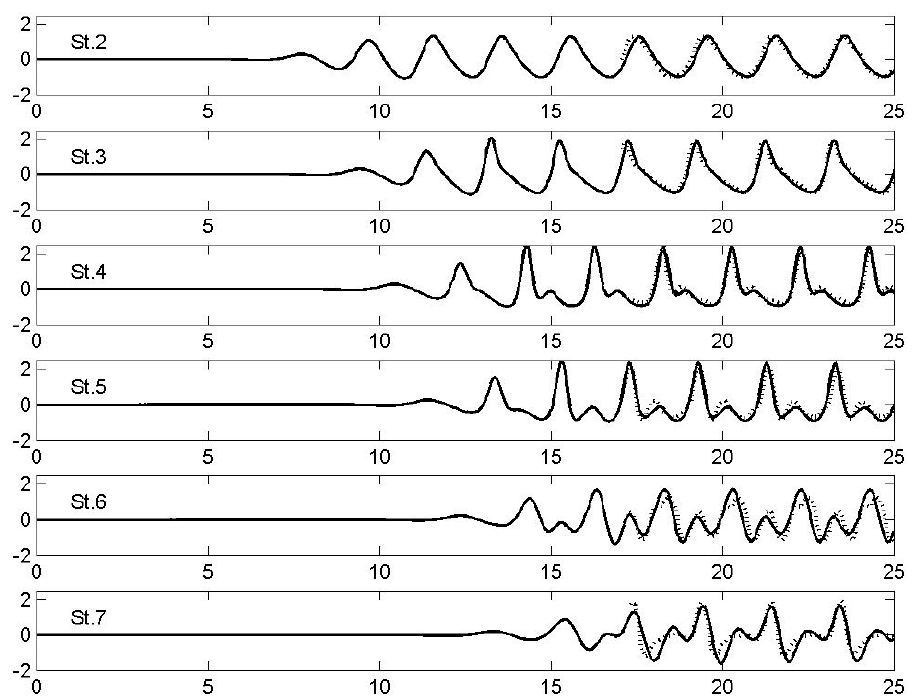
Figure 11. Horizontal and vertical flow components in the case of monochromatic incident waves of period T = 2 s and a height of 2 cm propagating over a trapezoidal bar, as calculated by the present nonlinear simplified model. The bathymetry is shown by using a thick solid line. Fluids 2019 , 4 , x FOR PEER REVIEW